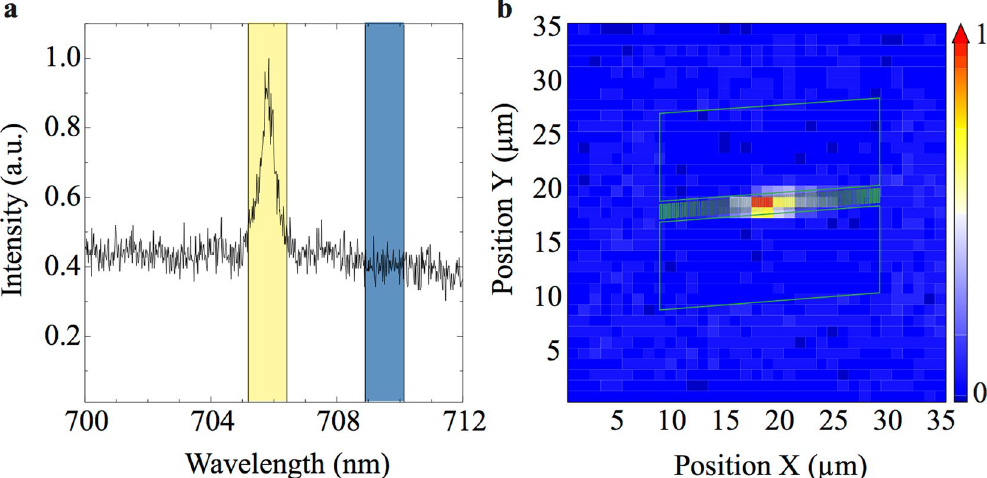
Figure 2. Spatial confinement. ( a ) M1 mode of a cavity with period p = 310 nm. The integrated intensity in the spectral region of the cavity mode (left yellow-shaded region) is subtracted from the background (integrated counts of the right blue-shaded region). ( b ) The resulting intensity distribution of the mode M1 shows strong spatial confinement at the center of the PCC (the green outline represents the ladder rungs and the RIE-etched regions defining the outer border of the